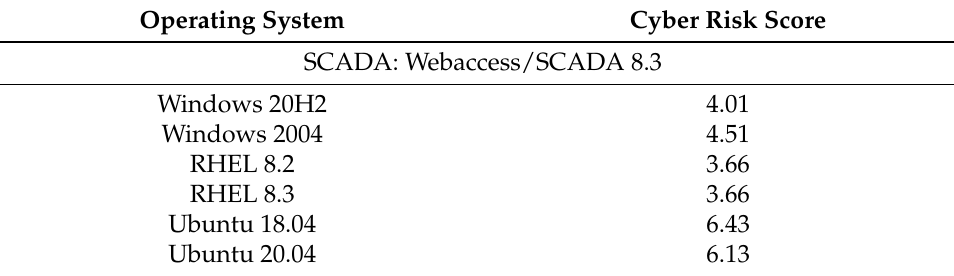
Table 6. Subset of cyber risk